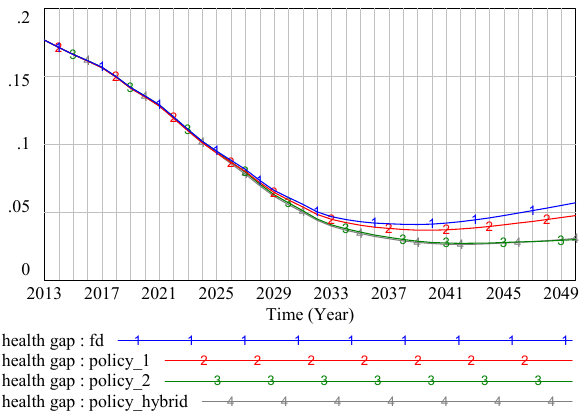
Figure 9. ( a ) Health status (Hybrid Scenario); ( b ) medical costs as a proportion of income (Hybrid Scenario); ( c ) doctor-visiting rate (Hybrid Scenario). Note: BAU scenario: SES–health disparity scenario; FD scenario: SES–FD–health disparity scenario; Policy 1 scenario: scenario with intervention policy of lower drug prices; Policy 2 scenario: scenario with intervention policy of higher income promotion for the low-SES group; Policy hybrid scenario: scenario with two intervention policies.